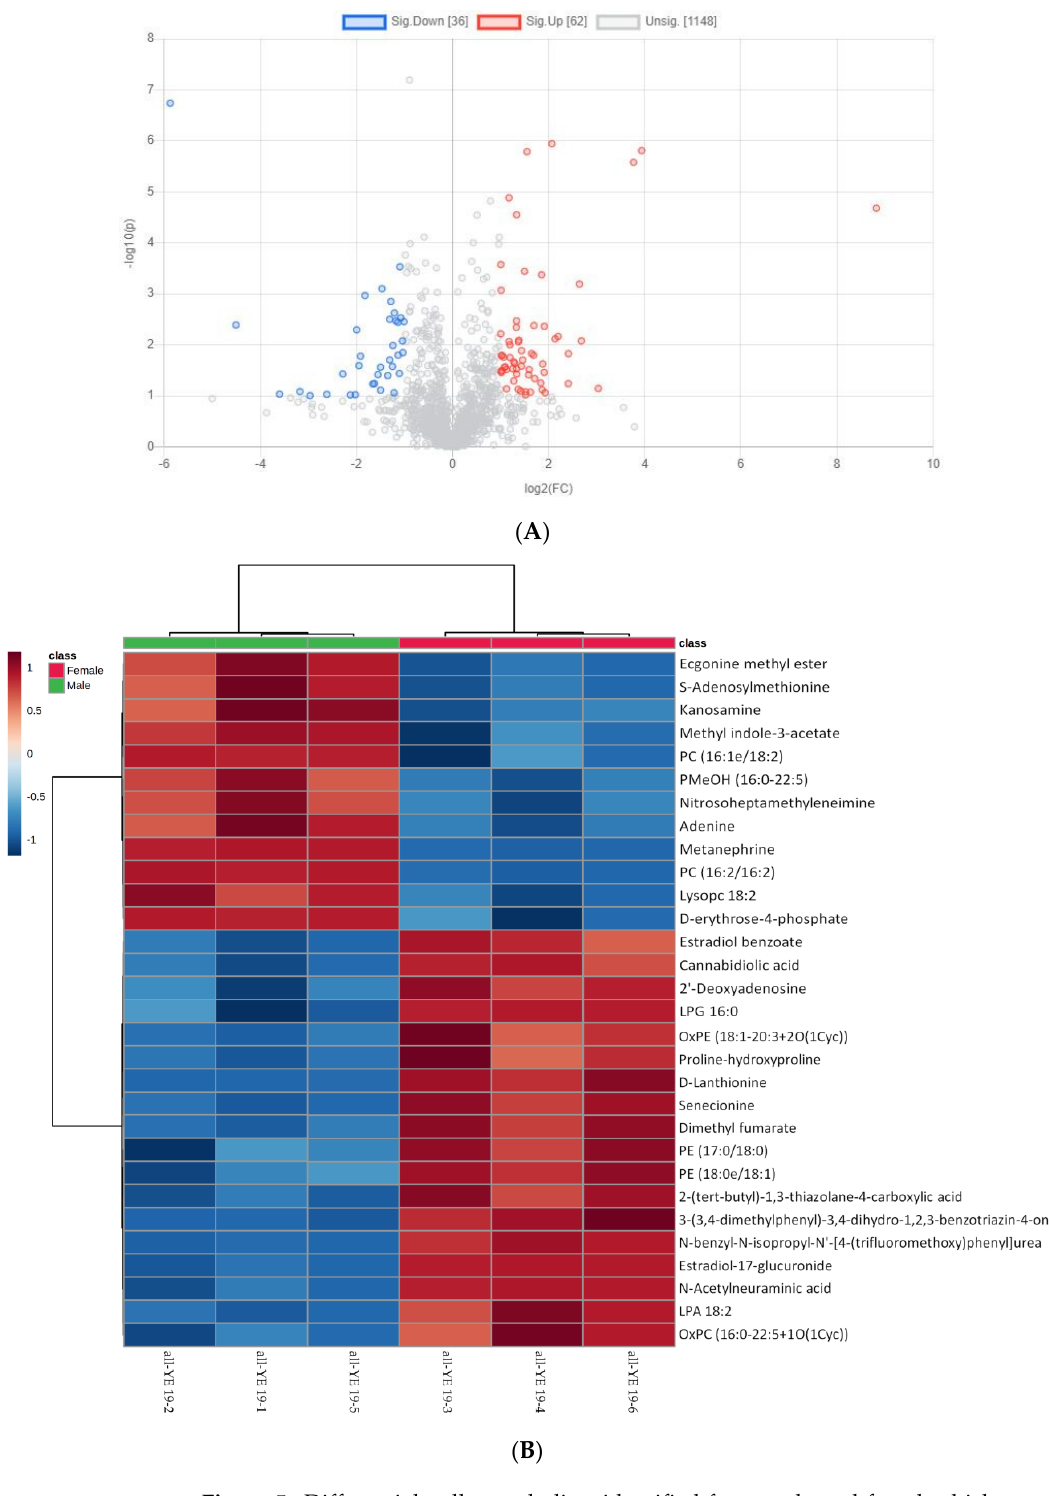
Figure 5. Differential yolk metabolites identified from male and female chicken embryos at E19 ( n = 3). ( A ) The volcano plot shows the combination of the fold changes and the p values of each metab- olite. The red dots represent the metabolites that were significantly upregulated in female birds, while the blue dots represent the metabolites that were significantly downregulated in female birds. ( B ) Heatmap showing the difference profile of yolk metabolites between male and female chicken embryos. Each cell in the plot corresponds to a normalized z-score value. Sample names are in col- umns and compound names are in rows.